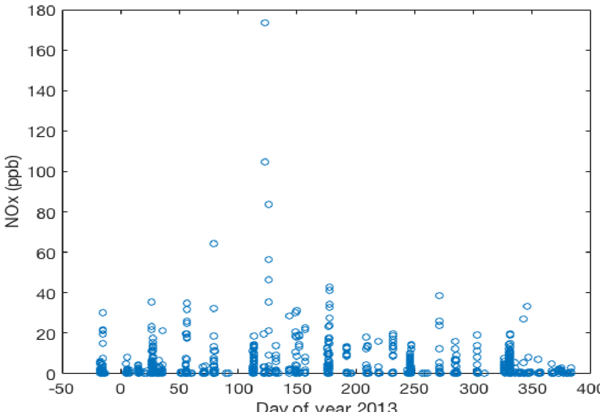
Figure 4. NO x measured from the above-surface inlets on the two snow towers and from all inlets on the meteorological tower. Cir- cles represent 10min averaged data. Plotted are data that were ex- tracted from occurrences when NO x was above 1ppb, well above the background mixing ratio, and any time when the wind direction was from the polluted wind